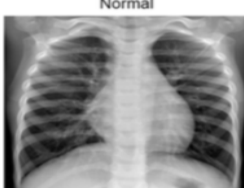
Figure 1. The normal chest radiograph depicts clear lungs in the